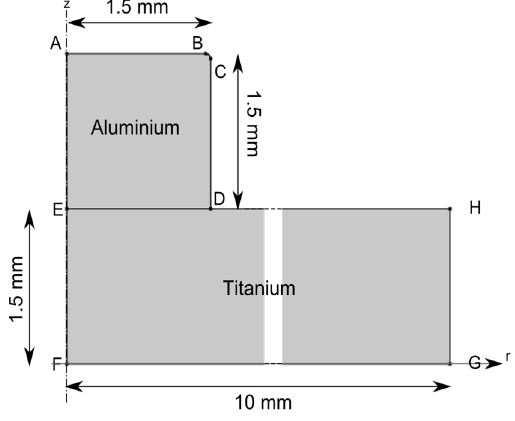
Figure 5. Geometrical model.